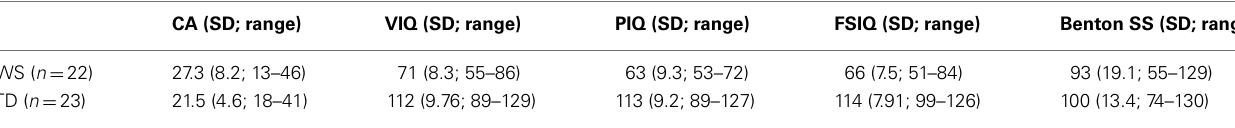
Table 1 | Mean characteristics of the participant groups (SD; range in parentheses) in Experiment